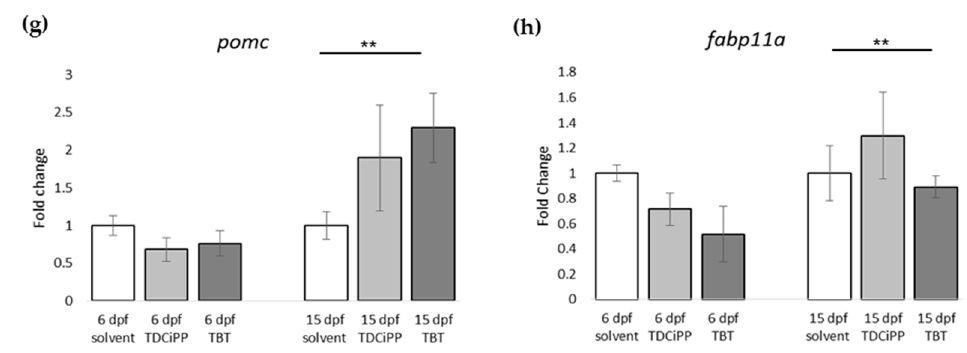
Figure 9. Gene expression of hormones and receptors after early exposure to environmental chemicals. ( a – h ) Fold change in expression of genes (normalized to solvent control at either 6 dpf or 15 dpf) were measured with qPCR using the obesity array. Samples were taken from two independent exposure experiments ( n = 3 per experiment); (** p ≤ 0.05). Error bars represent SEM.